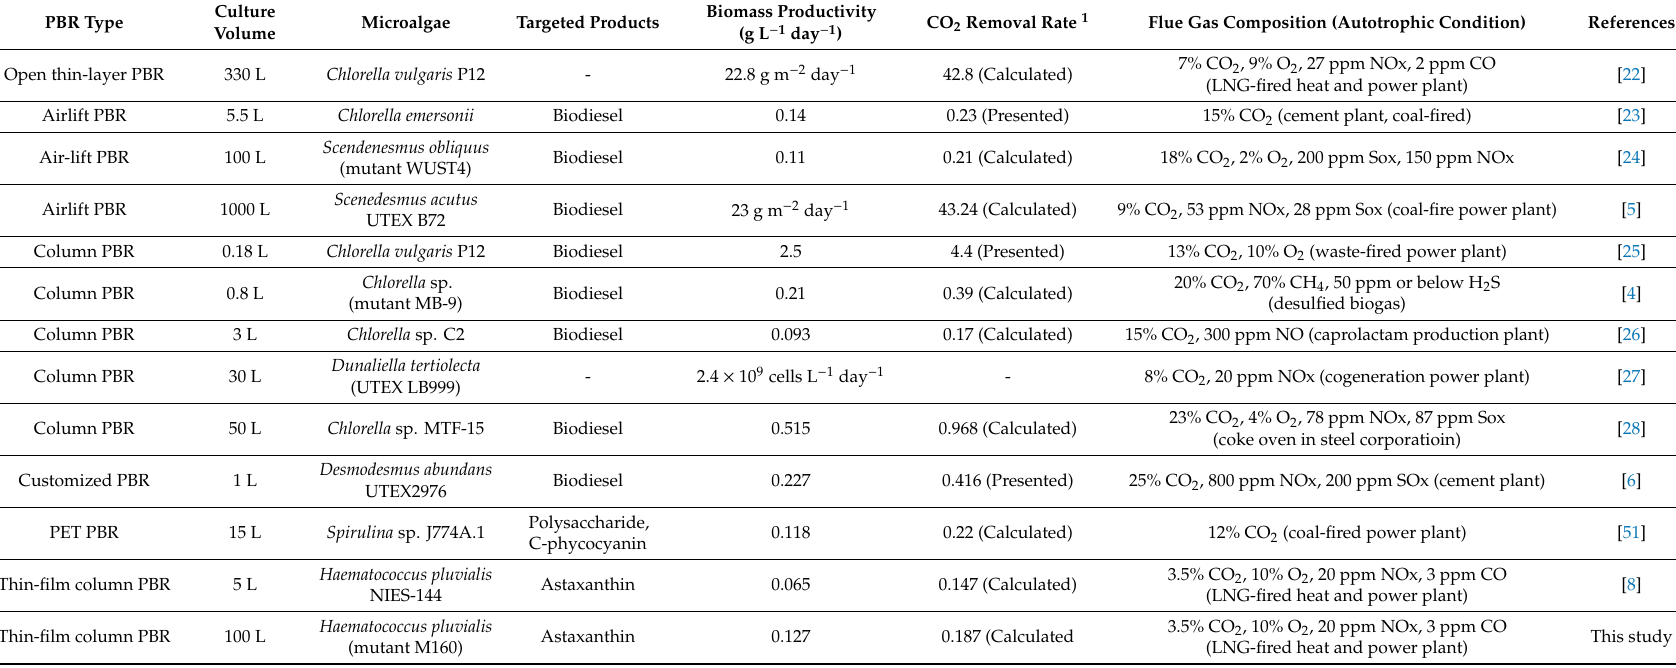
Table 4. Comparision of the performance of the bimass production and CO 2 removal rate from microalgae using industrial flue gas under di ff erent